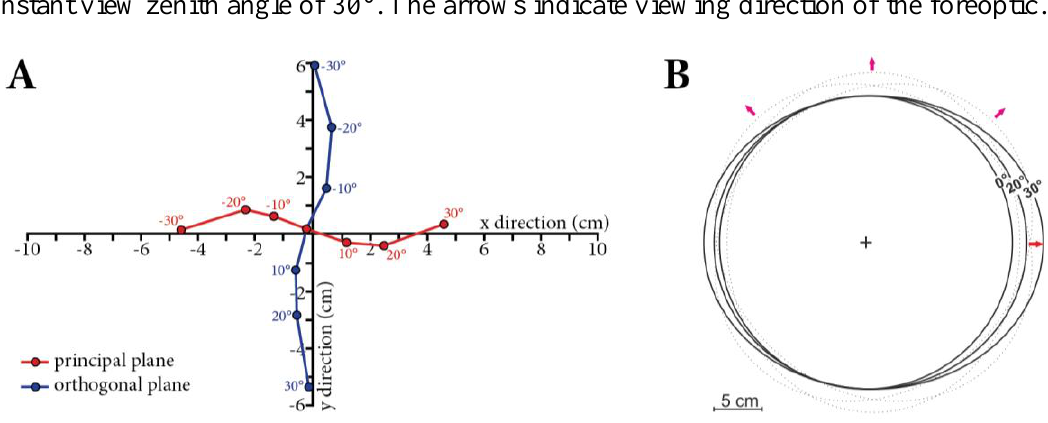
Figure 5. ( A ) Pointing accuracy of the ManTIS. The coordinate system center is aligned to the center of the target; ( B ) Ground instantaneous fields of view (GIFOV) for the range of view zenith angles of the ManTIS. The dotted lines show three view azimuth angles for a constant view zenith angle of 30°. The arrows indicate viewing direction of the